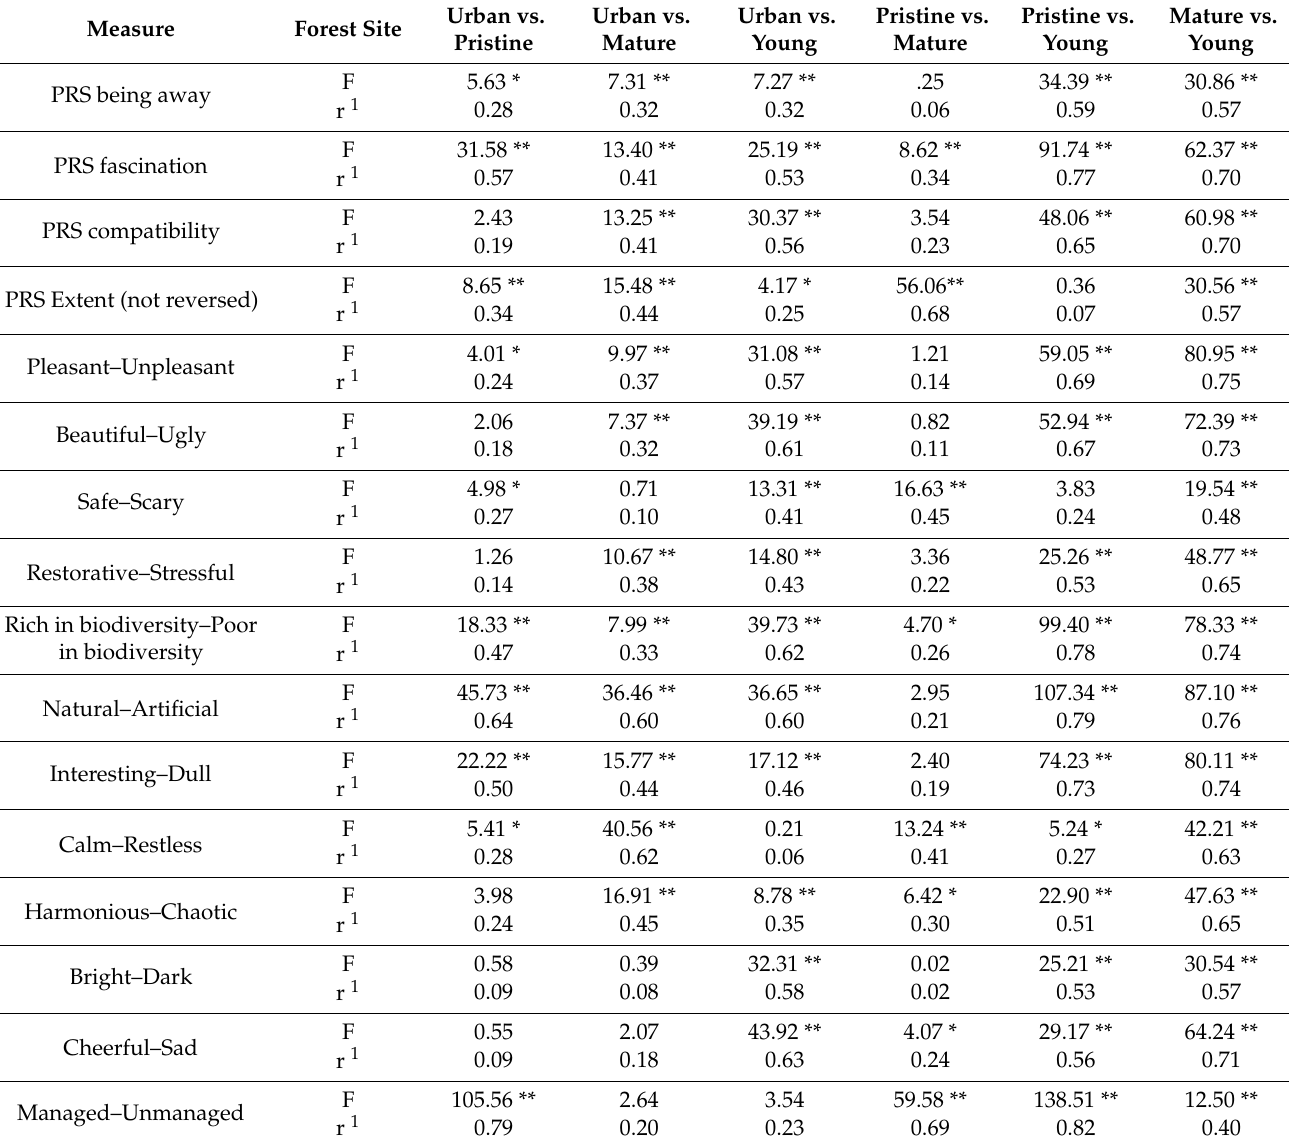
Table 3. Results of simple contrasts in repeated-measures analysis of variance (ANOVA), F statistics. Measure Forest Site